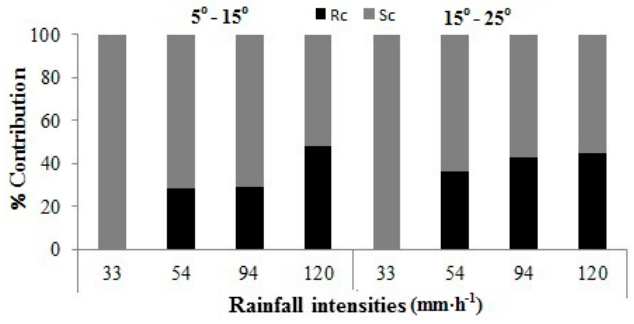
Figure 5. Rainfall (Rc) and slope (Sc) contributions for sediment losses under different rainfall intensities with increasing slope steepness from 5° to 15° and 15° to 25° in un ‐ mulched purple